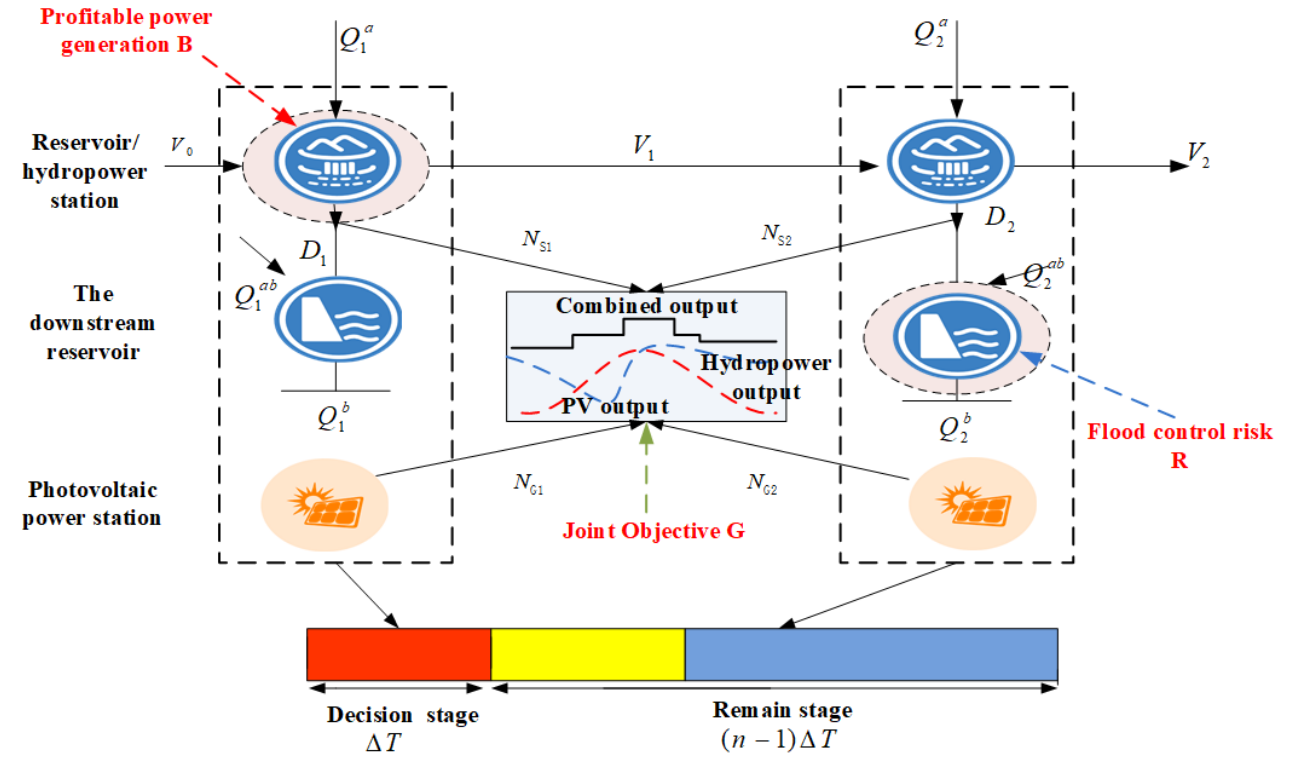
Figure 4. Schematic diagram of multi-objective decision-making in the two-stage for hydropower and photovoltaic joint power generation. Table 1. Decision variables of combined hydropower and photovoltaic power generation.